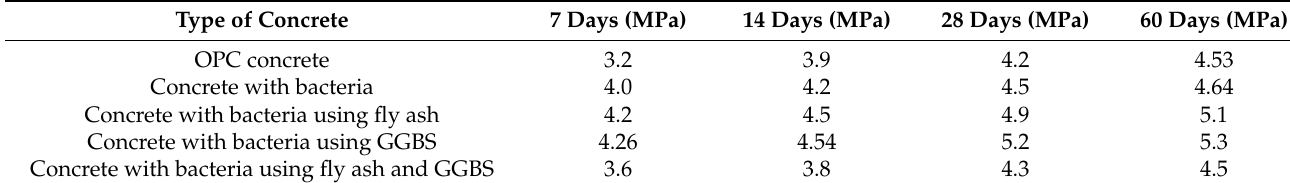
Table 10. Split tensile strength values for concretes with different compositions [53].